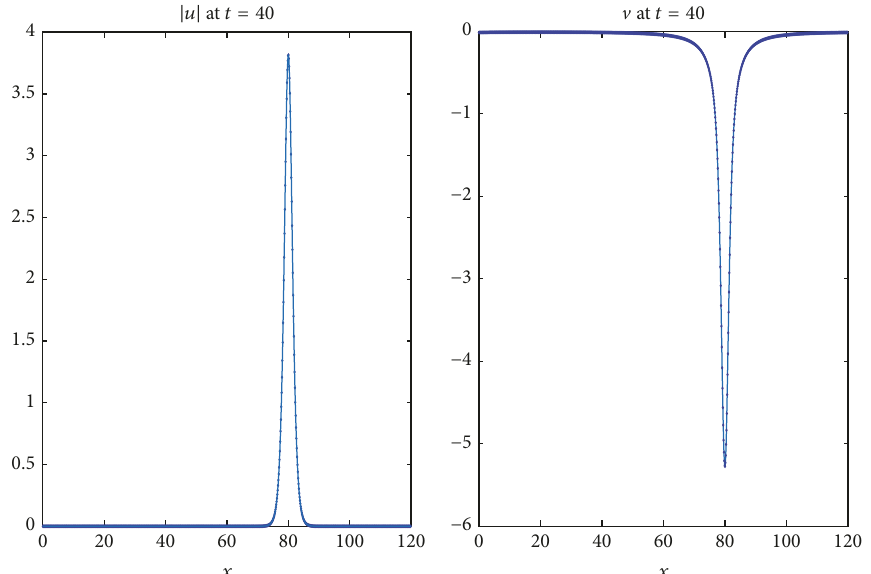
Figure 10: Evolution of a solitary wave solution (39) (with 𝜙, 𝜓 as in Figure 9) of the SBO system at 𝑡 = 40 . In solid line, |𝑢|, V computed with the numerical solver introduced in [14]. In pointed line, |𝑢|, V for the approximate solitary wave solution (39).